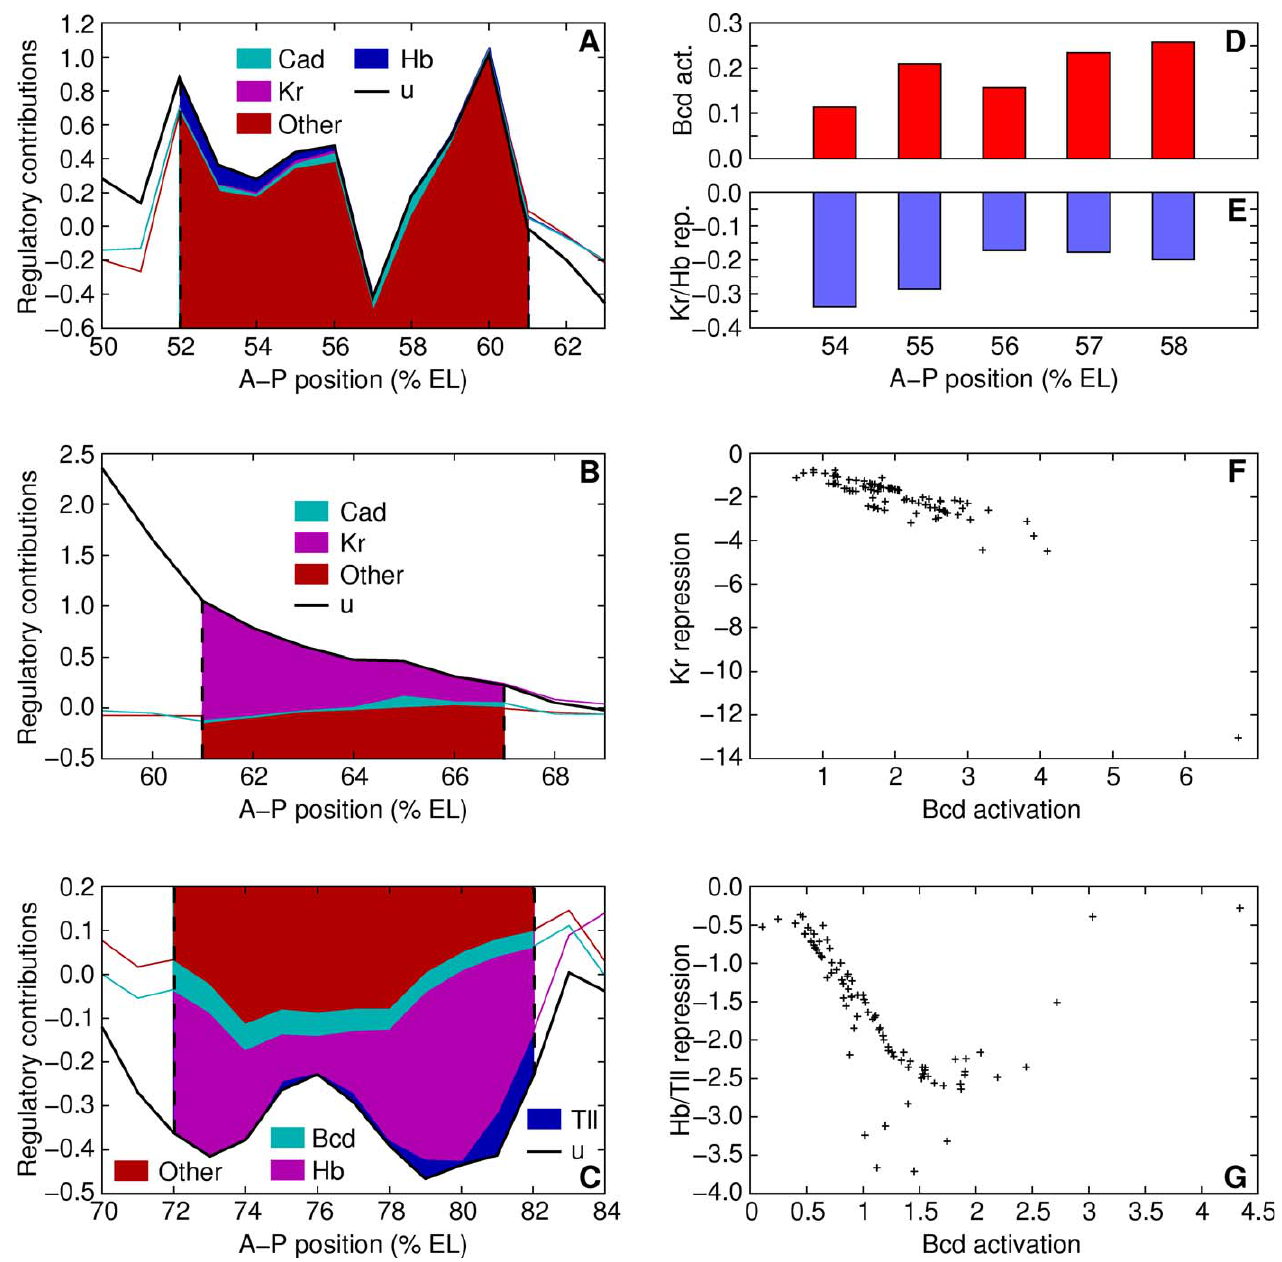
Figure 5. Regulatory Analysis of the Anterior Border of the Posterior kni Domain and Both Borders of the Posterior gt Domain (A–C) Analysis of the chosen gene circuit (see Results section ‘‘ Simulation of Bcd Variation and Size Variation ’’ ) with the median Bcd profile (Figure 2B). The graphical regulatory analysis is described in the caption of Figure 4. (A) The kni border forms because of the regulatory contributions of Cad activation, Kr repression, and Hb repression. (B) The anterior gt border is set by Cad activation and repression from Kr. (C) The posterior gt border is set by Bcd activation and repression from Hb and Tll. (D–G) The effects of simulated Bcd variation on the regulation of gap gene borders. (D) The average Bcd activation at the kni border in 88 simulations (with different Bcd profiles) pooled into 1% EL bins according to border position. (E) The average repression levels at the kni border in 88 simulations pooled into 1% EL bins according to border position. (F) Scatter plot of the Bcd activation and Kr repression at the anterior gt border in each of the 88 simulations. (G) Scatter plot of the Bcd activation and Hb/Tll repression at the posterior gt border in each of the 88 simulations. The repressors were identified in the regulatory analysis (A–C). The x- axis shows bin position. The analysis was performed on model output in time class T8.